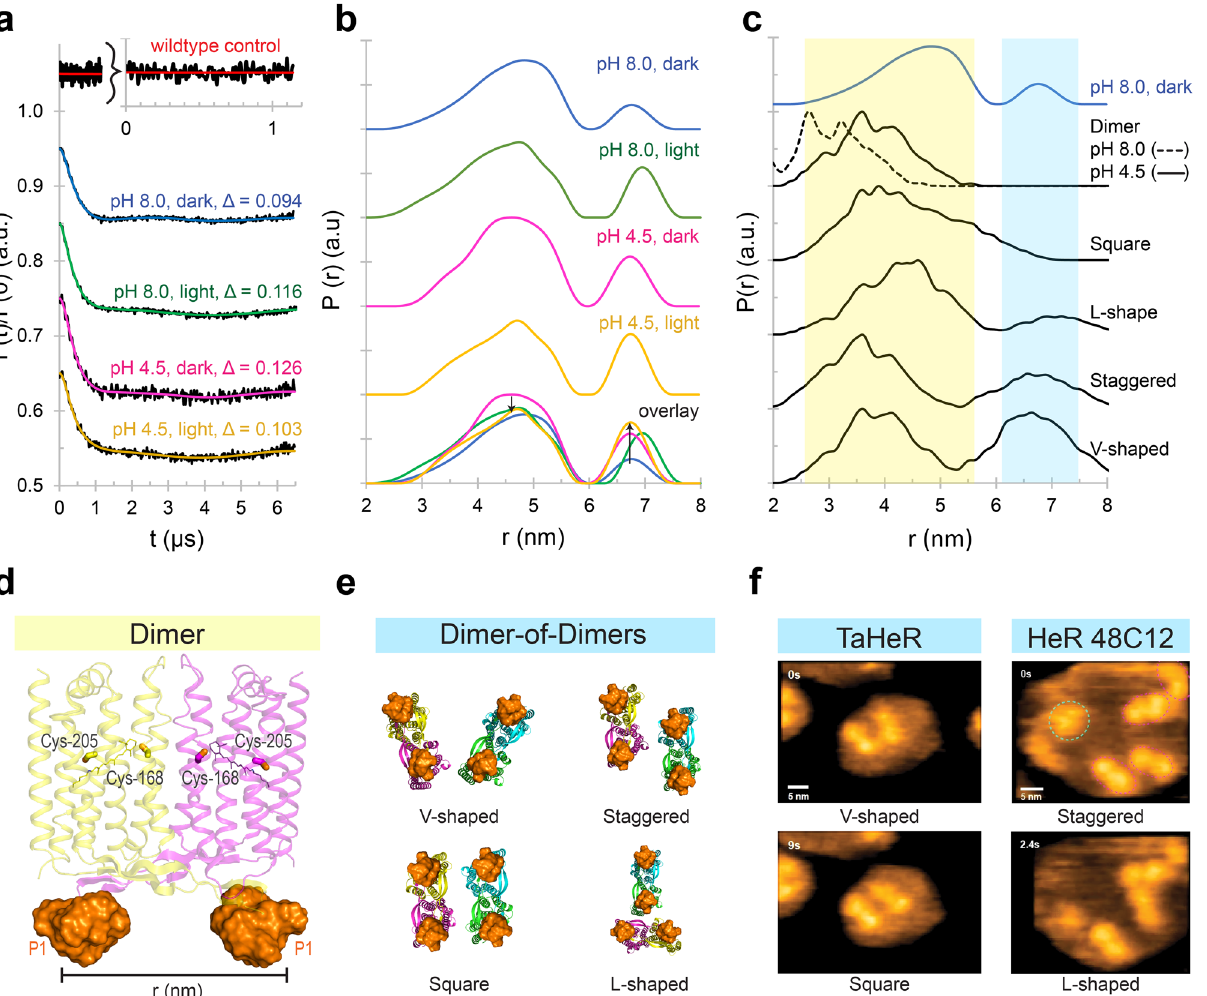
Figure 7. DEER of TaHeR-I51P1 suggests HeR can adopt dimer-of-dimer assemblies that are pH- and light- dependent. ( a ) The DEER dipolar evolution function of TaHeR-I51P1 with indicated modulation depth (Δ) at pH 8 and pH 4.5 in dark and light conditions. The inset (red) shows data from wildtype TaHeR incubated with IAP spin label. Here, the lack of dipolar interactions indicated that native cysteines could not be sufficiently spin-labelled. ( b ) The DEER distance distribution, P(r), revealed two spatially separated peaks at 4.7 nm and 6.6 nm. The experimental parameters allow for accurate distance distributions up to 5.9 nm and mean distances up to 7.4 nm 24 . Relative to the pH 8 dark sample, light or acidification increases the population of the 6.6 nm peak (up arrow). Relative to the pH 4.5 dark sample, illumination slightly decreases the population of the 4.7 nm peak (down arrow). DEER experiments were performed in duplicate. ( c ) MMM distance distributions of dimer and dimer-of-dimer assemblies compared to the pH 8 dark sample. Dimer-of-dimer assemblies were generated from AlphaFold (square, L-shaped) or PyMOL (staggered, V-shaped), with corresponding models shown in panel e. ( d ) Model of the TaHeR-I51P1 dimer with the P1 rotamer cloud (orange surface) from the pH 4.5 structure. The two native cysteines, Cys-168 and Cys-205, are inaccessible to spin-labelling. ( e ) Dimer-of- dimer models with P1 rotamer clouds (orange surface). ( f ) HS-AFM images of TaHeR and HeR 48C12 from the supplementary videos of ref. 16 showing similar dimer-of-dimer assemblies. Reprinted by permission from CCC: Springer Nature Shihoya et al. (2019) 16